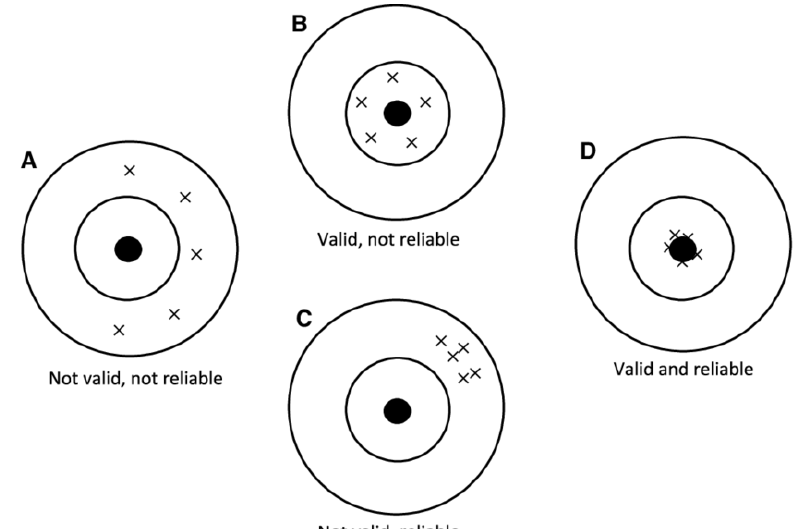
Fig. 3. Possible combinations of validity and reliability of measurement instruments